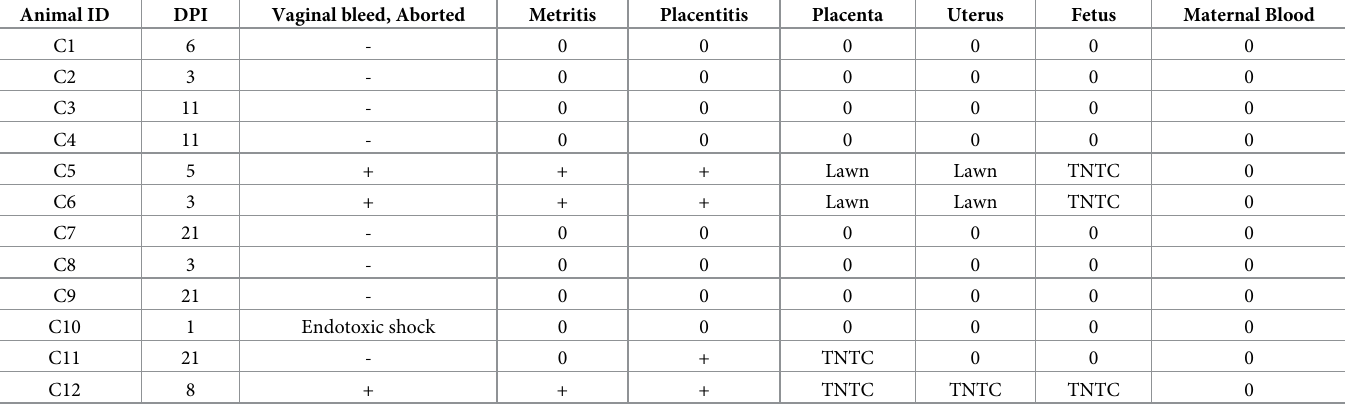
Lawn: Culture plate completely covered with bacterial colonies. TNTC; Too numerous to count. DPI: Number of days post-campylobacter challenge the animal was euthanized. fetal or maternal tissues from these animals. Gimenez stained sections of placenta/placentome